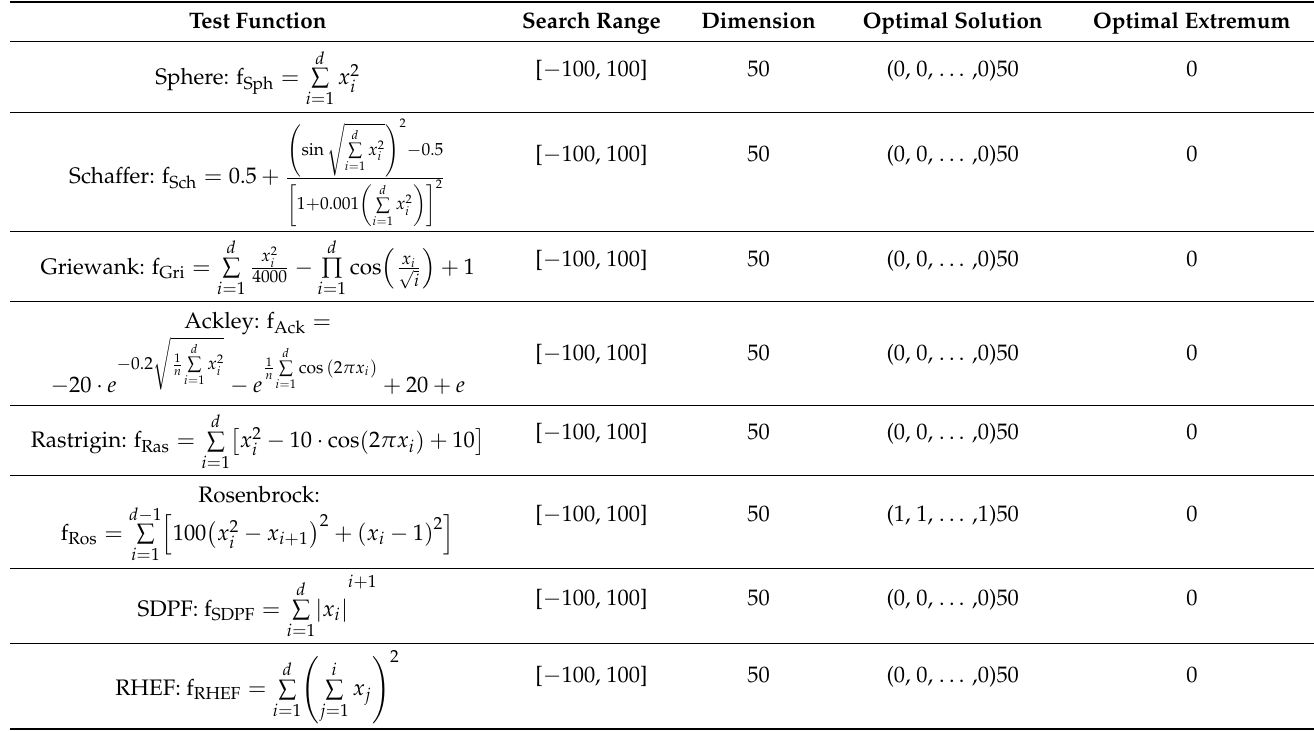
Table 1. Parameters for radio